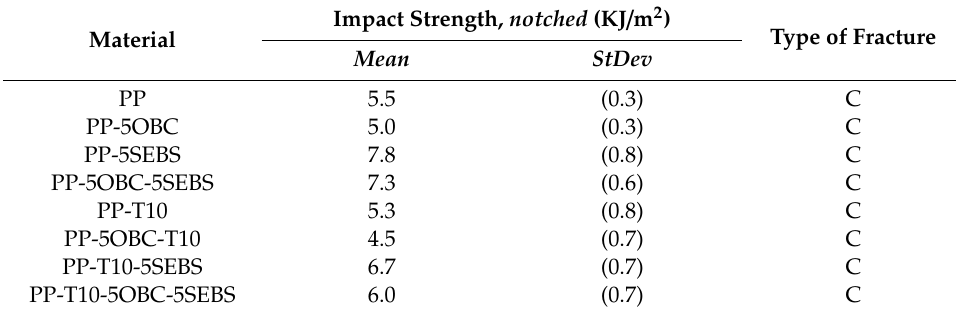
Table 3. Results of notched Izod impact tests.